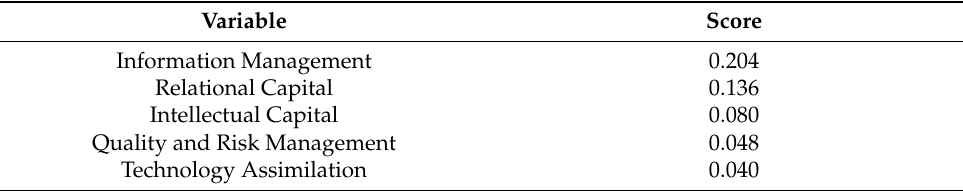
Table 3. Most relevant variables in knowledge